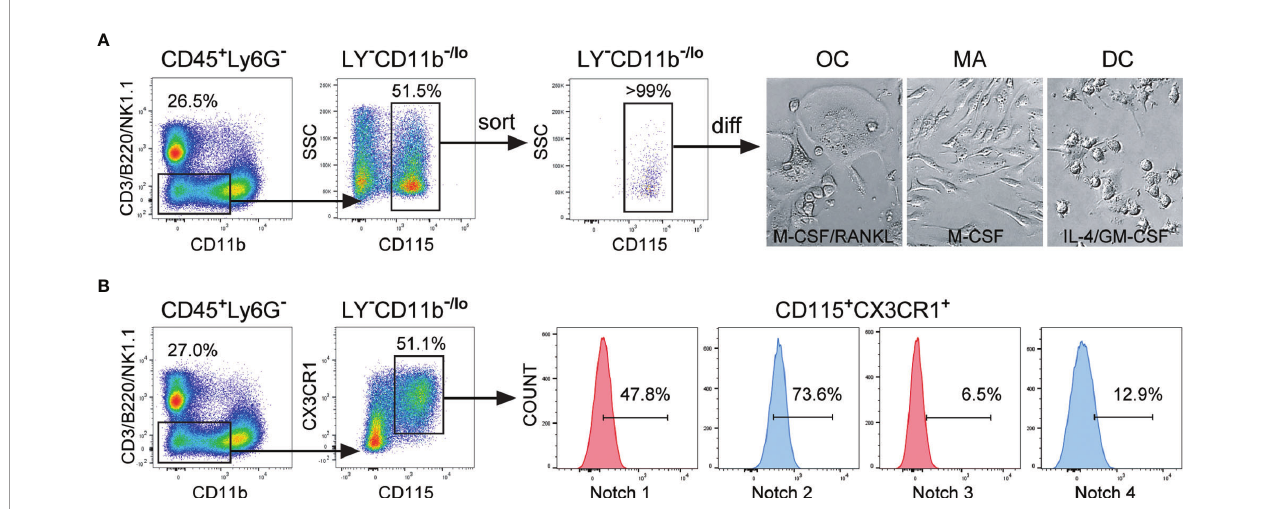
FIGURE 1 | Expression of Notch receptors by the common trilineage progenitor isolated from the bone marrow cells of C57BL/6 mice. Bone marrow cells were fl ushed from hind limb long bones and the common trilineage progenitors were identi fi ed as CD45 + Ly6G − CD3 − B220 − NK1.1 − CD11b – /lo CD115 + cells using fl ow- cytometry. (A) Trilineage progenitor cells have the ability to differentiate into osteoclasts (OC), macrophages (MA) and dendritic cells (DC), under appropriate culture conditions. Sorting ef fi ciency of the common trilineage progenitor was above 99%. Differentiation of OCs was induced by receptor activator of nuclear factor k B ligand (RANKL) and macrophage colony-stimulating factor (M-CSF); MAs by M-CSF; DCs by interleukin 4 (IL-4) and granulocyte-macrophage colony-stimulating factor (GM-CSF). Representative bright fi eld images show typical morphology of differentiated unstained OCs, MAs and DCs. (B) Trilineage progenitor cells express the chemokine receptor CX3CR1, justifying the use of CX3CR1CreERT2 mice to modulate Notch signaling. In addition, the progenitor population expresses different percentages of Notch receptors (Notch 1 through Notch 4), as determined by fl ow cytometry. Representative histograms for Notch receptor expression on CX3CR1 + trilineage progenitors are shown. LY − – CD3 − B220 − NK1.1 −